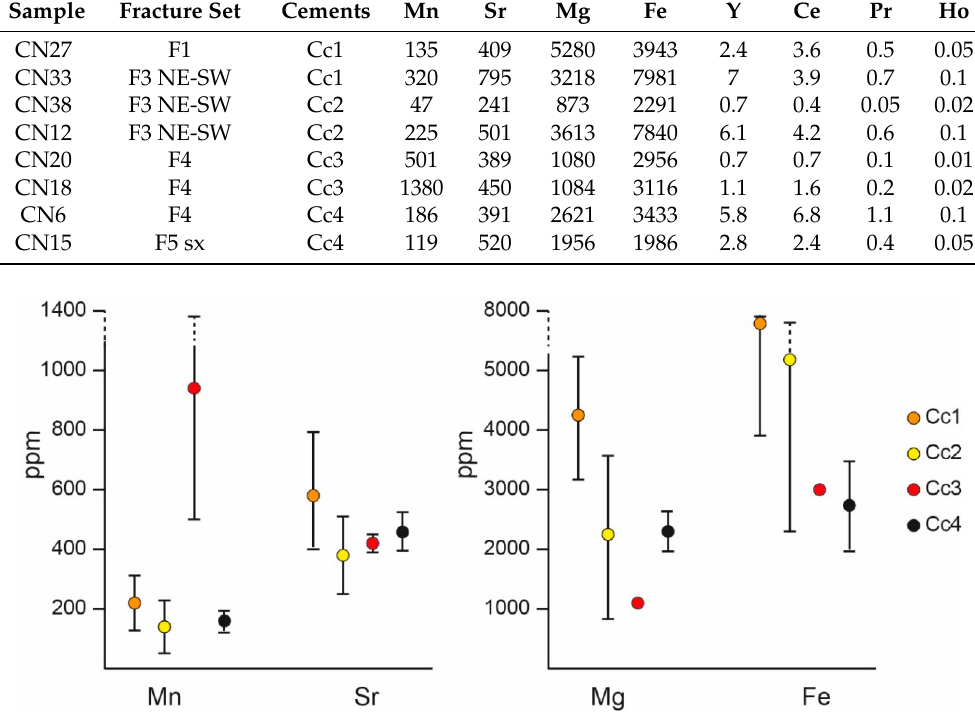
Table 3. Elemental composition of the different generations of calcite cements. Values are given in ppm. Sample